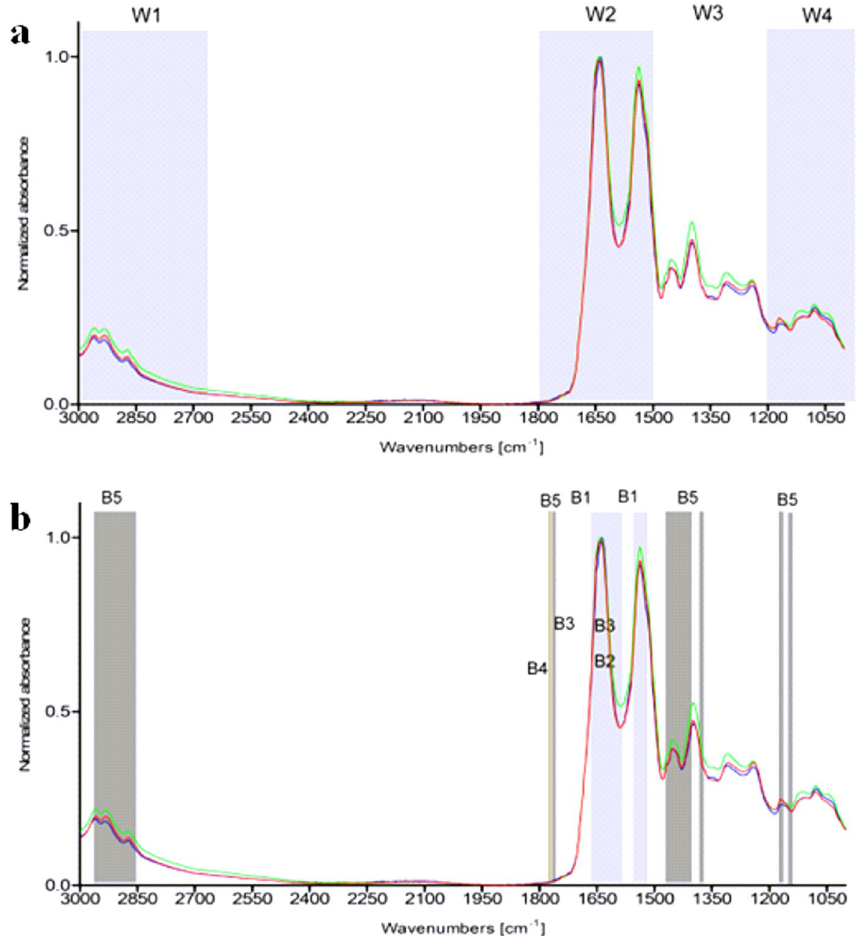
Figure 1. Representative infrared spectra of investigated human sera: green—CHD patients infected with H. pylori , red—healthy blood donors H. pylori positive and blue— H. pylori negative healthy individuals. ( a representative spectra. W1–W4 correspond to the characteristic fragments of fatty acids (W1 3000–2800 cm −1 ); peptides and proteins (W2 1800–1500 cm −1 ); proteins, phosphate-carrying compounds and fatty acids (W3 1500–1200 cm −1 ); carbohydrates (W4 1200–900 cm −1 ). ( b ) Part of IR spectra most differentiating the study groups. B1–B5 show characteristic absorption band differentiating in this study, see Table